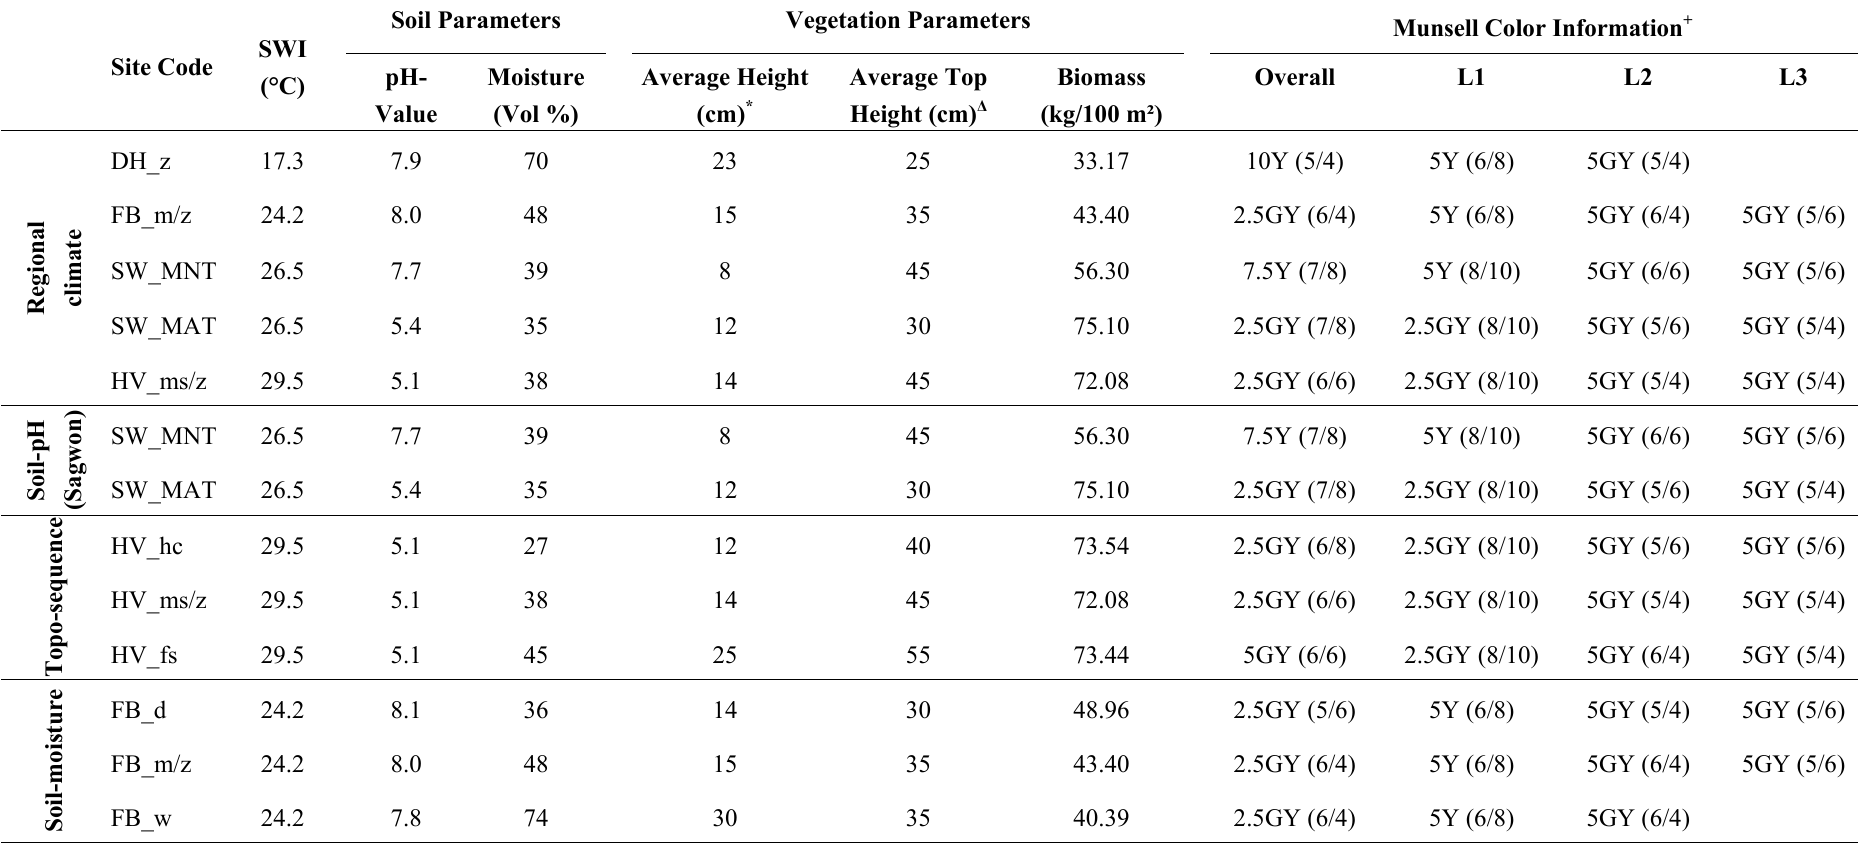
Table 2. Geoecological characteristics of the nine study sites. All parameters were collected during the EyeSight-NAAT-Alaska expedition 2012, except the values for SWI, soil pH and biomass, which were obtained from Raynolds et al.